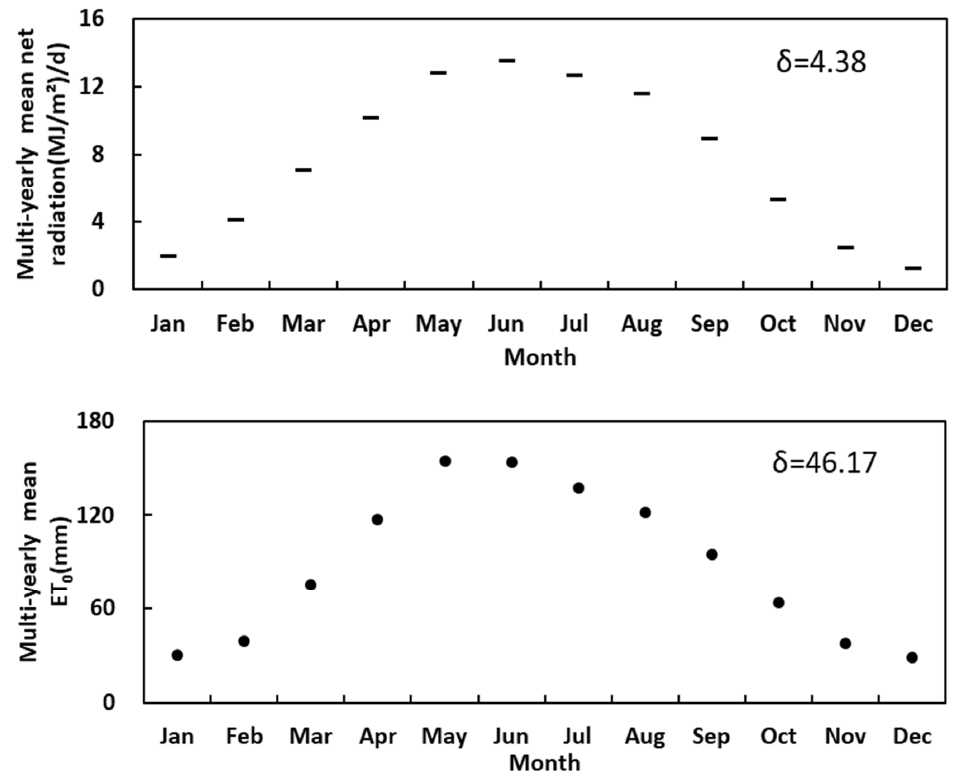
Figure 2. Annual variations in meteorological factors and potential evapotranspiration (ET 0 ) based on multiannual averages. The δ means standard deviations, illustrating annual variability of meteorological parameters. A higher standard deviation indicates meteorological factor values are more dispersed, while a lower value indicates more concentrated.